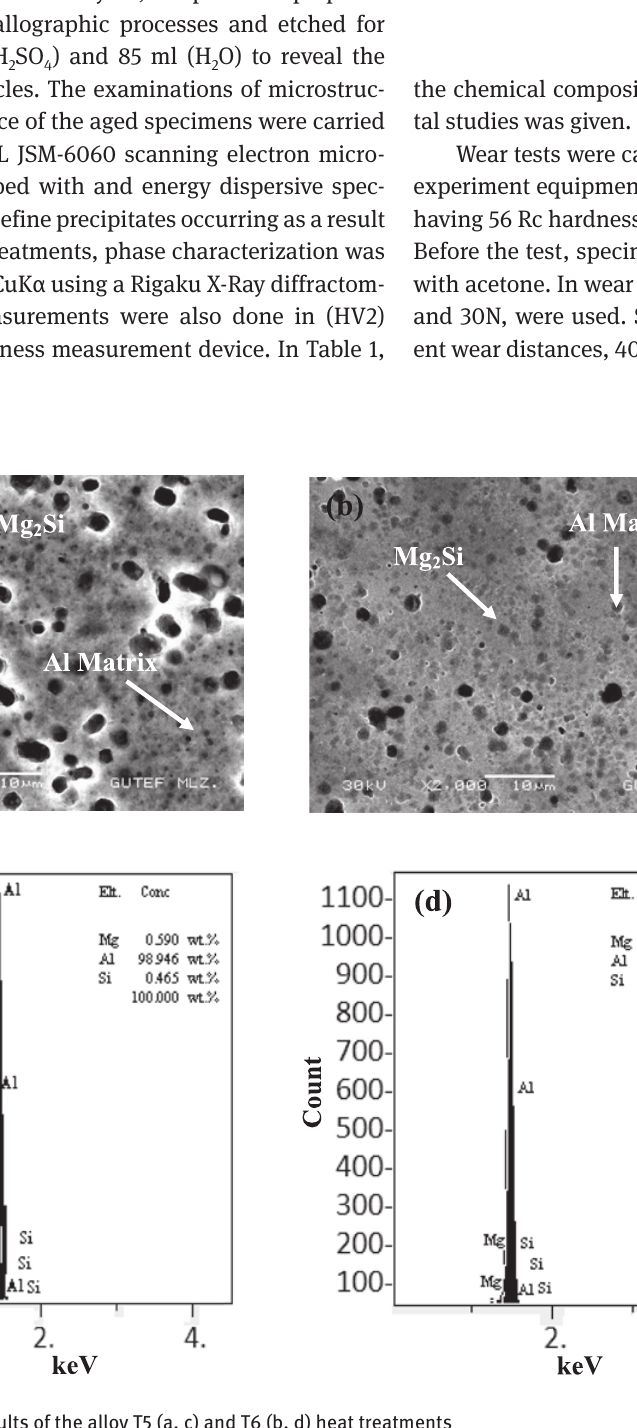
Fig. 1: SEM and EDS results of the alloy T5 (a, c) and T6 (b, d) heat